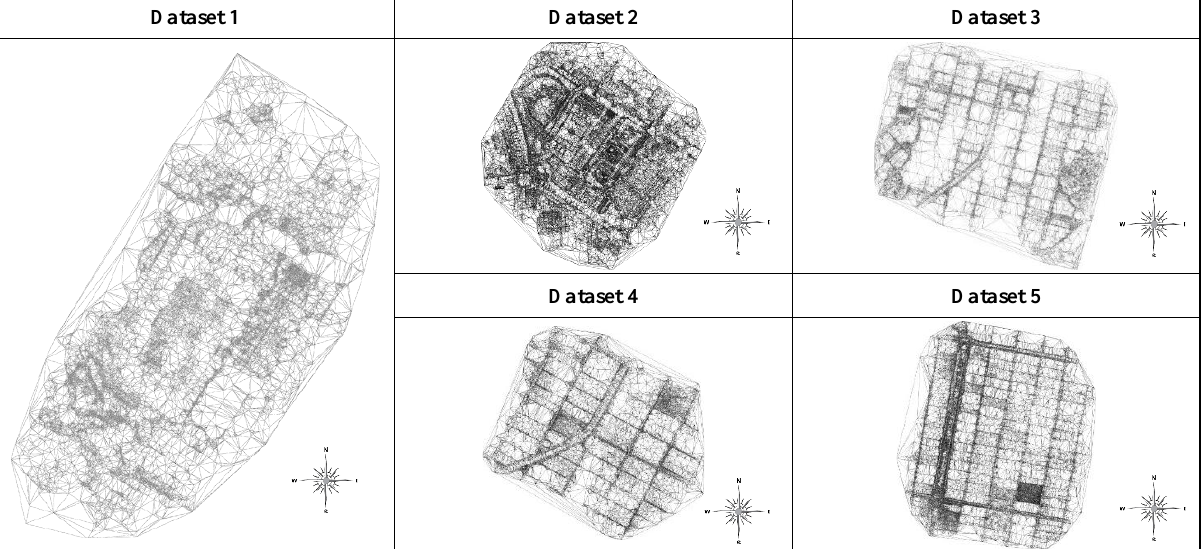
Table 6. TIN generation results of the proposed method